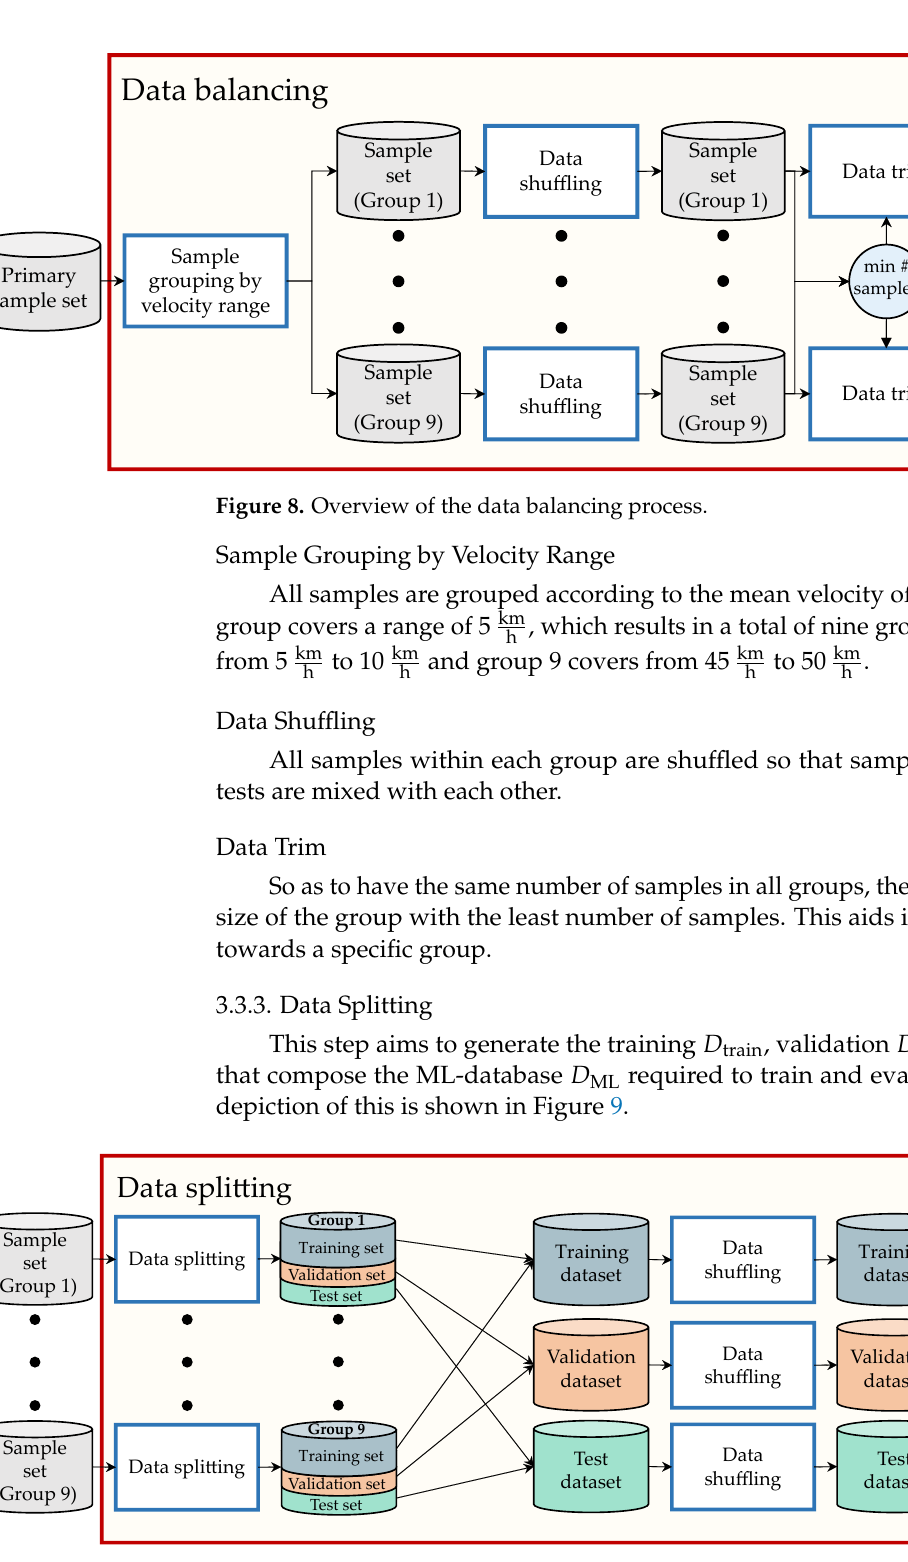
Figure 9. Overview of the data splitting